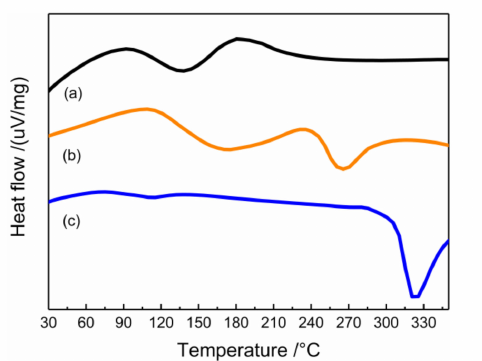
Figure 7. Di ff erential scanning calorimetry (DSC) curves for core-shell fiber and PAN fiber. (a) The reaction between epoxy and the amine healing agent; (b) the multiple-chamber, core-shell nanofibers; (c) the PAN